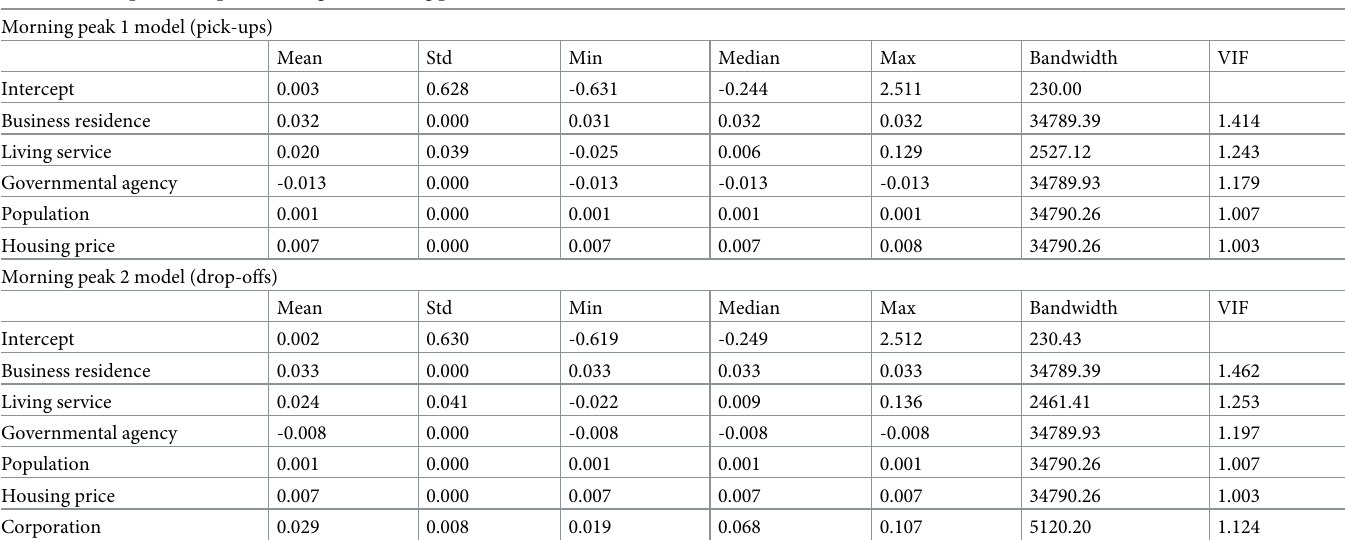
Table 3. Pick-ups and drop-offs during the morning peak. Morning peak 1 model